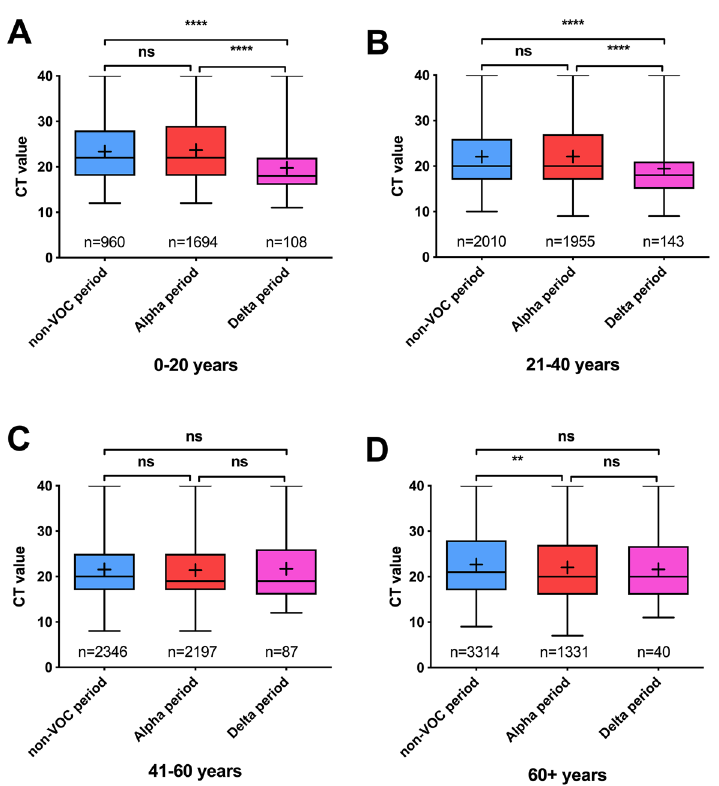
Figure 3. CT values per time period dominated by non-VOC (Dec 2020–Feb 2020), Alpha (Mar 2020–Jun 2020) and Delta (Jul 2020) SARS-CoV-2 variants for age groups 0–20 ( A ), 21–40 ( B ), 41–60 ( C ) and 60+ years